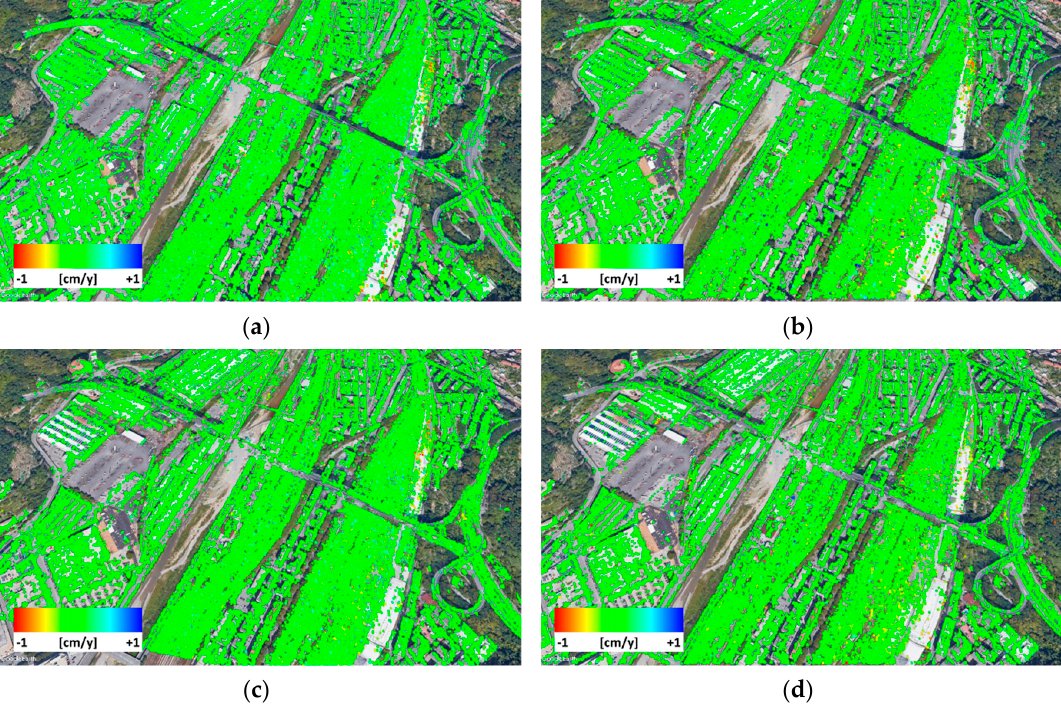
Figure 3. Mean deformation velocity maps over the area of interest for ( a ) Small BAseline Subset (SBAS) and ( b ) TomoSAR processing results achieved for the ascending dataset, and ( c ) SBAS and ( d ) TomoSAR results relevant to the descending dataset. Colormap is set according to the estimated velocity with the convention that negative values correspond to departure from the sensor along the LOS. Reference pixels for SBAS and TomoSAR processing are located at [44.4130°, 8.8879°] and [44.4160°, 8.8738°], respectively, which are in stable areas far away from the bridge.